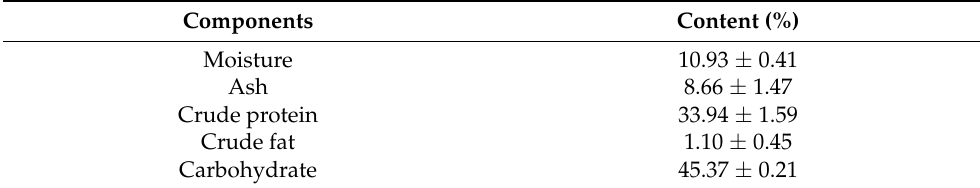
Table 1. The proximity analysis of Porphyra